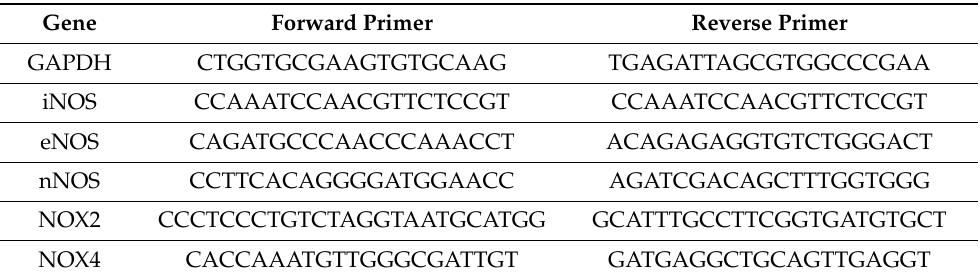
Table 1. Quantitative RT-PCR primers